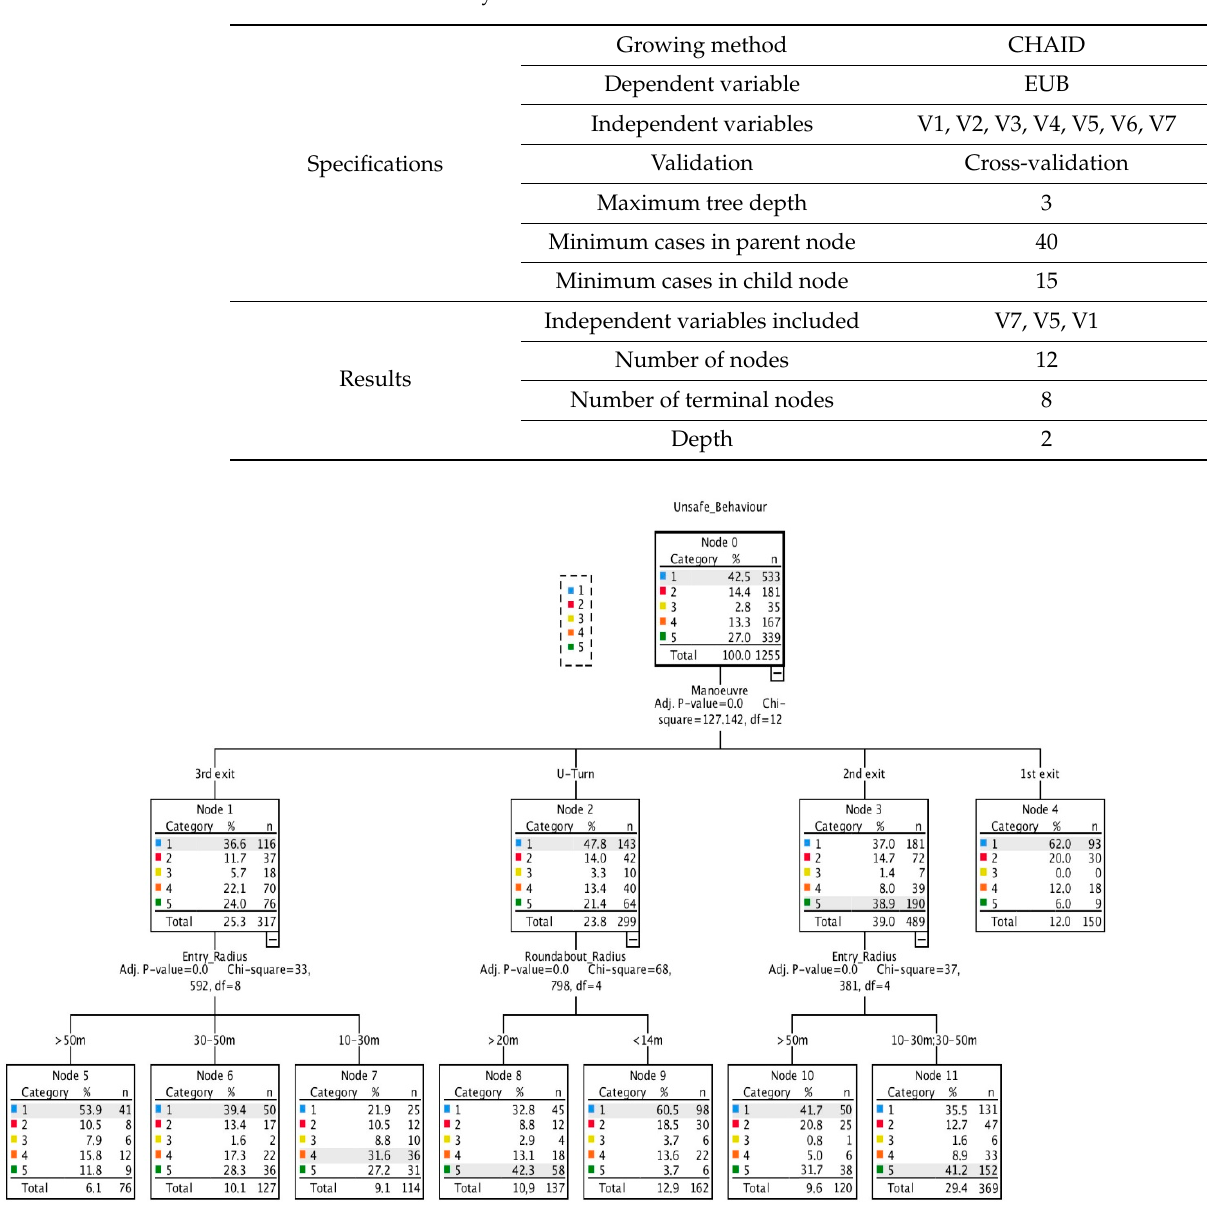
Table 6. Method summary.